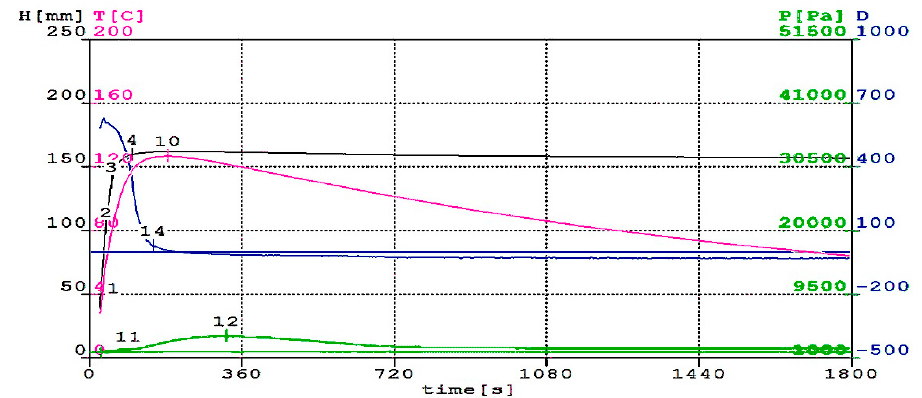
Figure 2. Change in height (H), temperature (T), pressure (p) and dielectric polarization (D) of reaction mixture during foaming process for M0 foam without